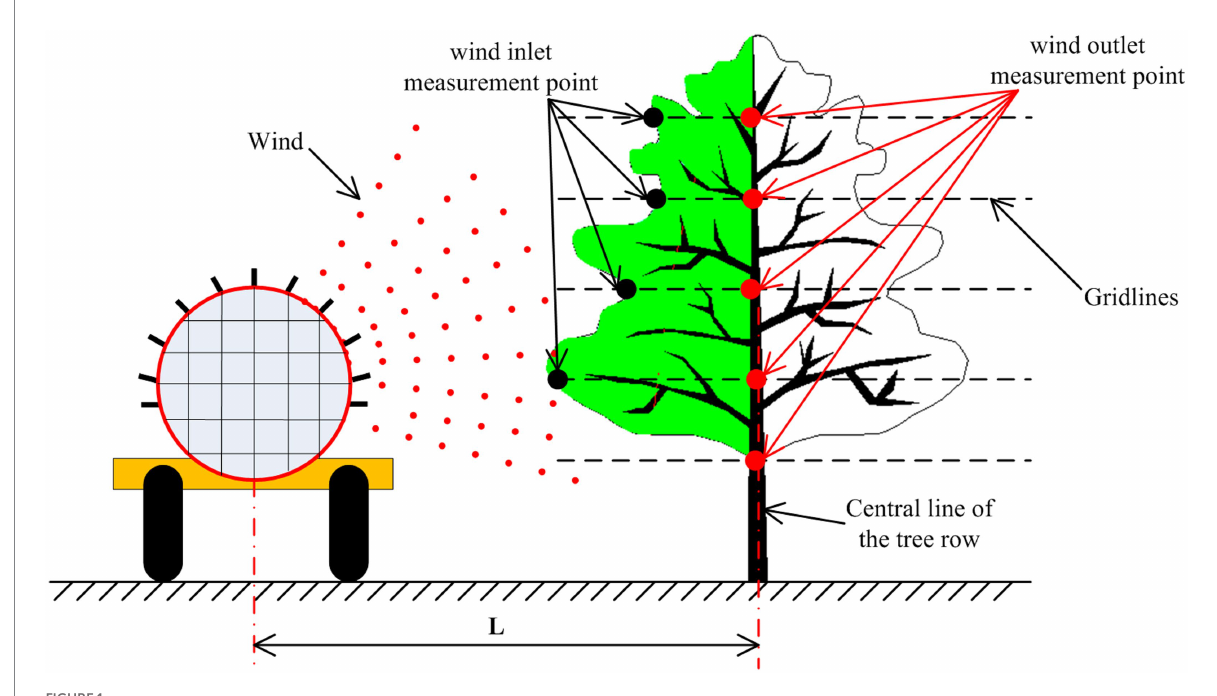
FIGURE 1 Schematic diagram of the canopy wind